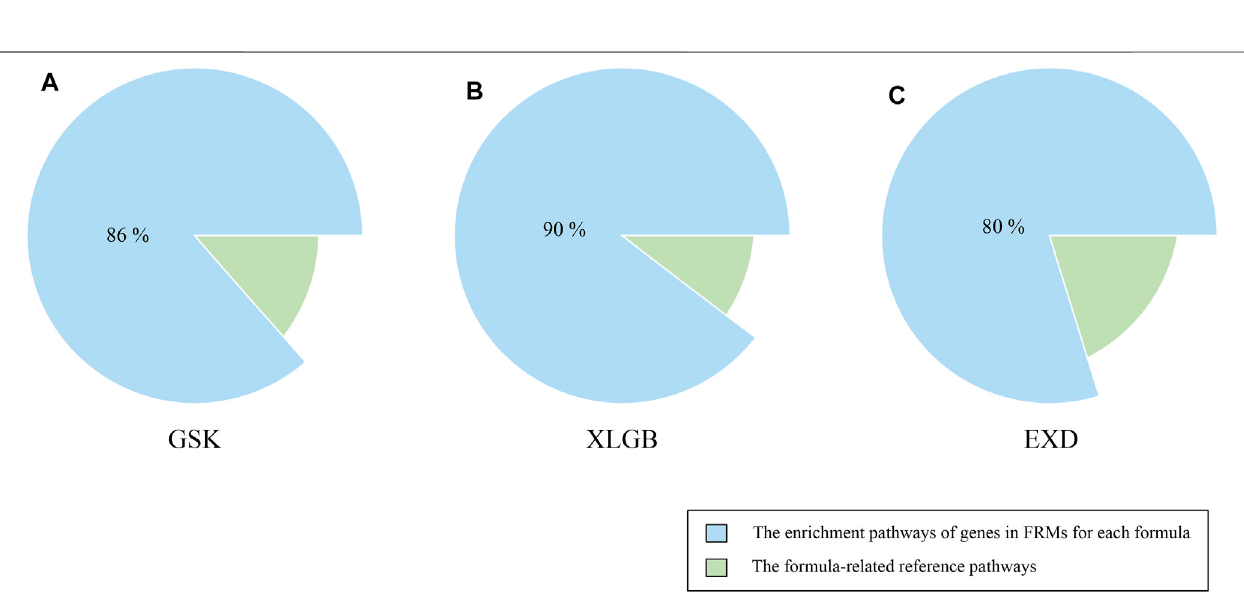
Frontiers in Cell and Developmental Biology |